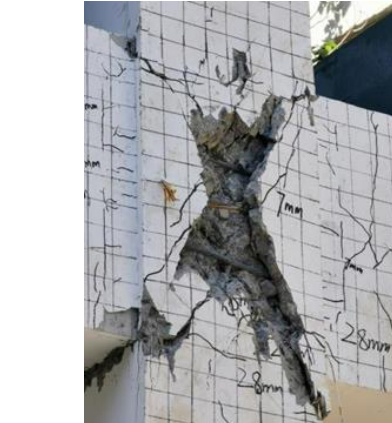
Figure 14. Crack development and failure of specimen ZJ-3.